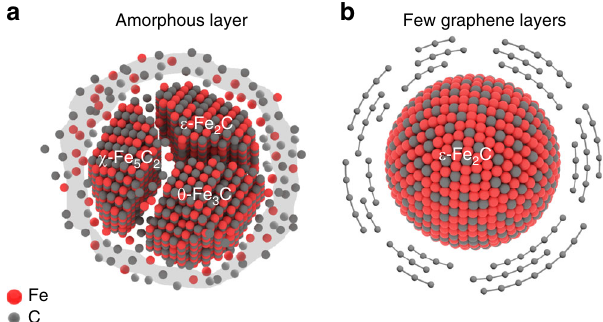
Fig. 1 Schematic models of iron-based catalysts for Fischer – Tropsch synthesis. a Conventional catalysts with uncon fi ned iron carbide (Fe x C) particles as the active phase. b Graphene layer-con fi ned ε -Fe 2